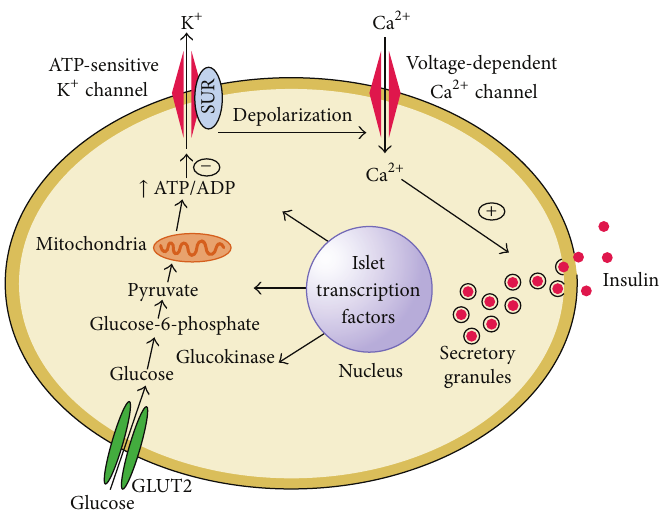
Figure 3: Diabetes and abnormalities in glucose-stimulated insulin secretion (adapted from